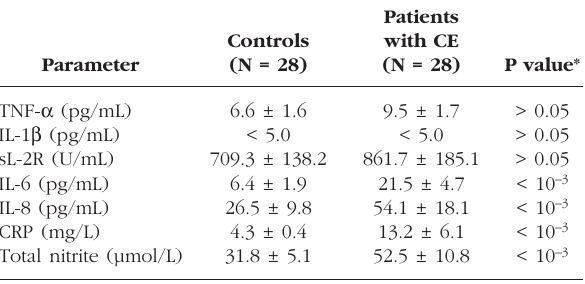
Table I. – Comparison serum cytokines, nitrate/nitrite and CRP levels (Mean ± SD) in studied subjects.